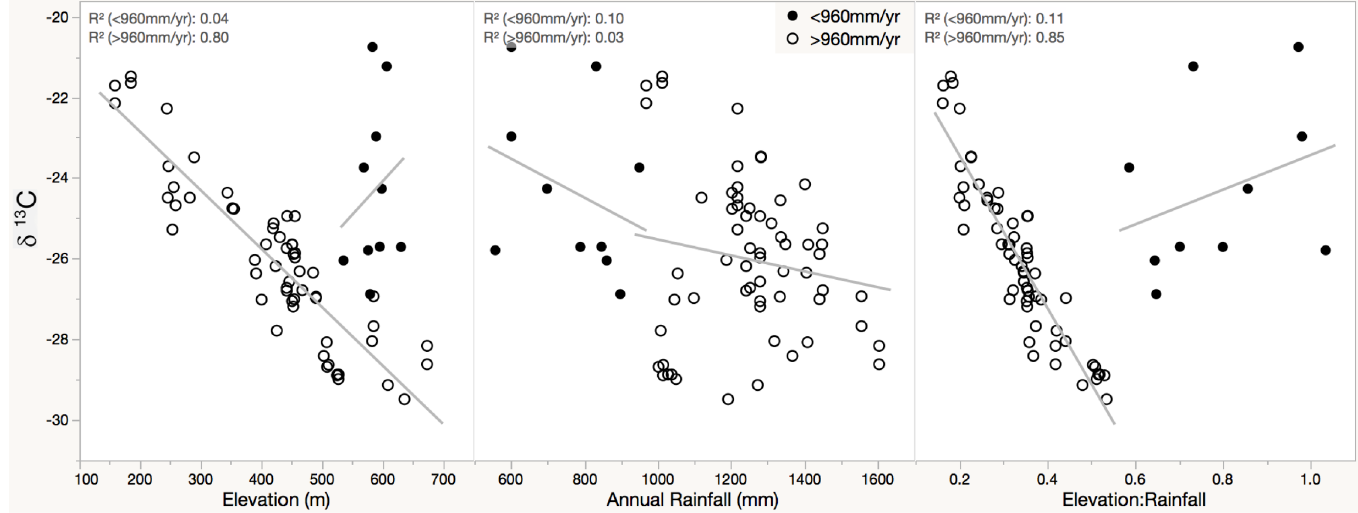
Fig 2. δ 13 C values in kukui endocarp. Response of δ 13 C to elevation, rainfall, and the ratio of elevation:rainfall; solid dots represent sites that receive an annual rainfall of less than 970 mm/yr of rainfall, and hollow dots represent sites that receive an annual rainfall of more than 970 mm/yr.